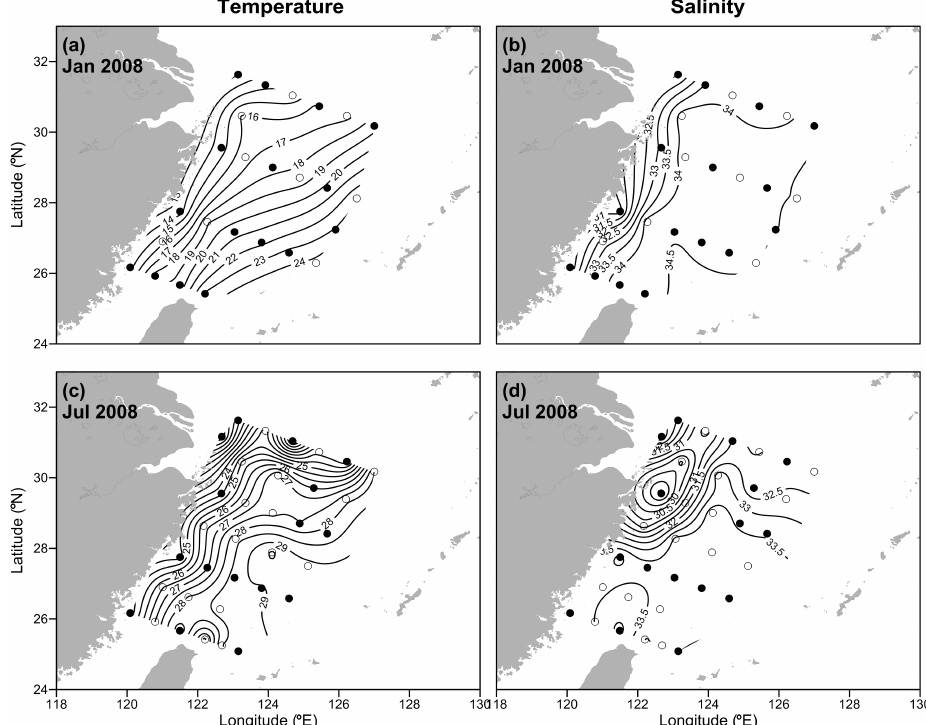
Fig. 4. Spatial distributions of temperature and salinity isopleths at the depths of 10m in the ECS, 2008 (open circles, stations with CTD data only; solid circles, stations with both CTD data and the data from the fish larval sampling).